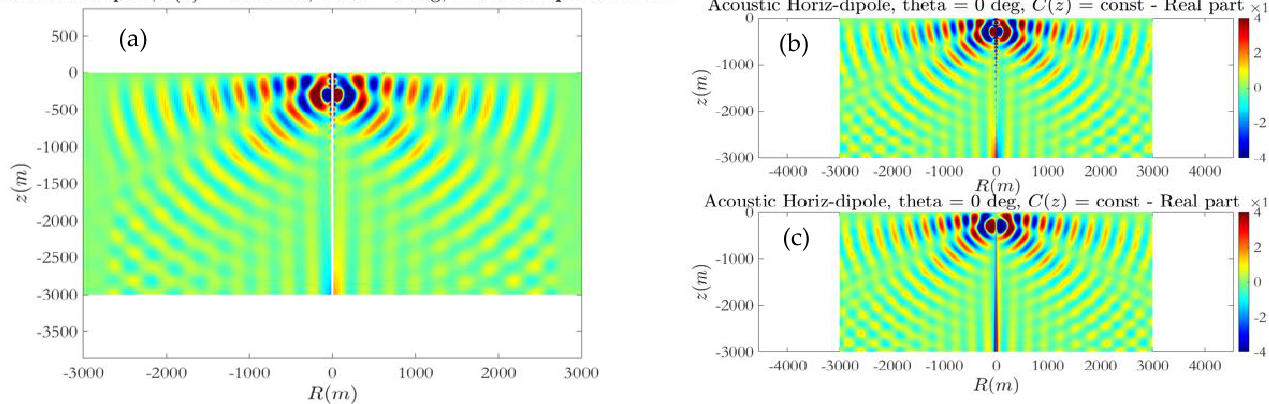
Figure 16. ( a ) The acoustic field obtained using the solution of the FDTD–PML numerical scheme excited by a horizontal dipole source of frequency f = 5 Hz located at a depth of 300 m with an impedance bottom boundary condition in an isovelocity environment. ( b , c ) Real and imaginary parts of the acoustic field obtained using the solution of the Helmholtz equation excited by a horizontal dipole source of frequency f = 5 Hz located at a depth of 300 m with an impedance boundary condition.